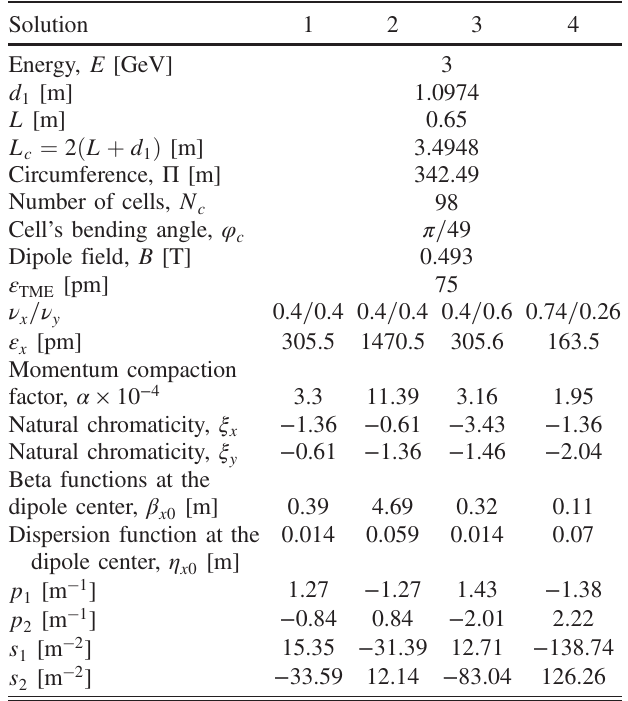
TABLE I. Main parameters of the four